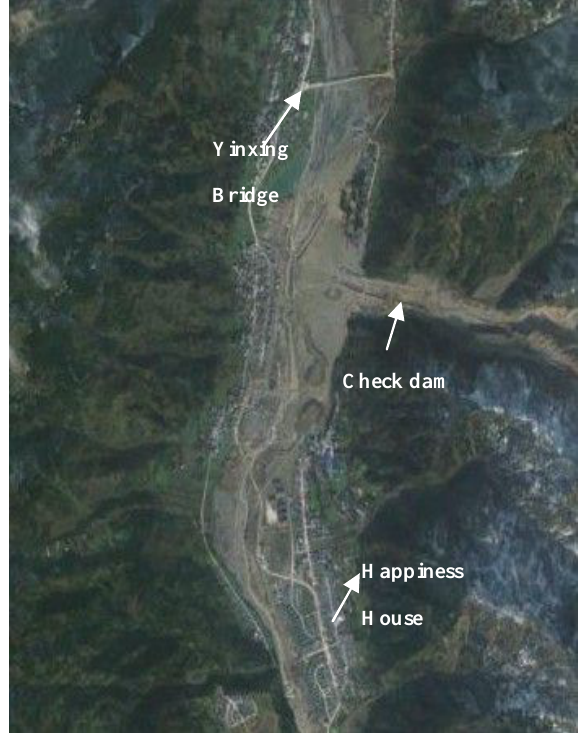
Figure 4. Satellite image of the study area in detail (from Google) Fig. 4. Satellite image of the study area in detail (from Google).